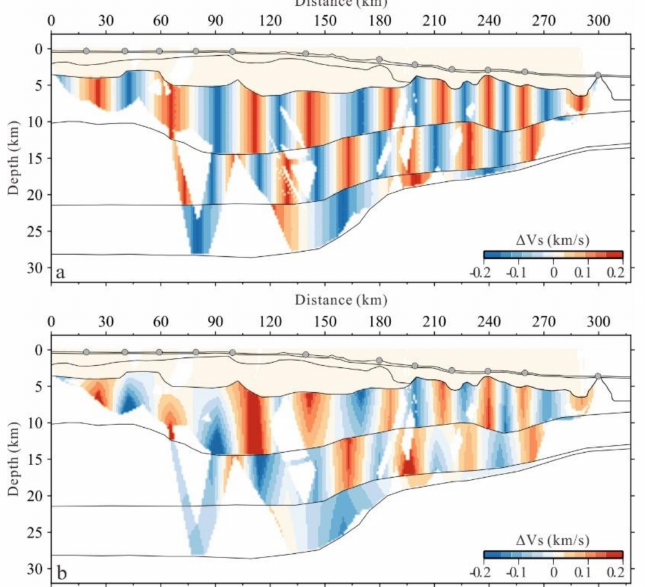
Figure 13. ( a ) Synthetic S-wave velocity perturbation using a checkerboard test. ( b ) Calculated S-wave velocity perturbation for the checkerboard test. The horizontal size of the anomalous block was 15–25 km in the upper crust, 20–40 km in the lower crust, the vertical size was bounded by